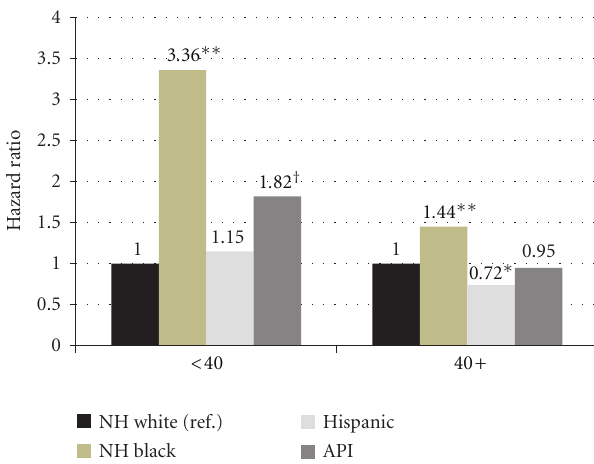
Figure 2: Non-Cancer Related Causes of Death 1975-2009 SEER 9: Race/Ethnicity Hazard Ratios. Model controls for his- tological subtype, stage, race/ethnicity, marital status, metropoli- tan/nonmetropolitan county designations, radiation treatment, surgical treatment, and diagnosis year; ∗∗ P < 0 . 0001; ∗ P < 0 . 01; † P < 0 . 05. Table 4: Distribution of Causes of Death by Age Group: 1975–2009 SEER 9 (Follow-Up through December 31,